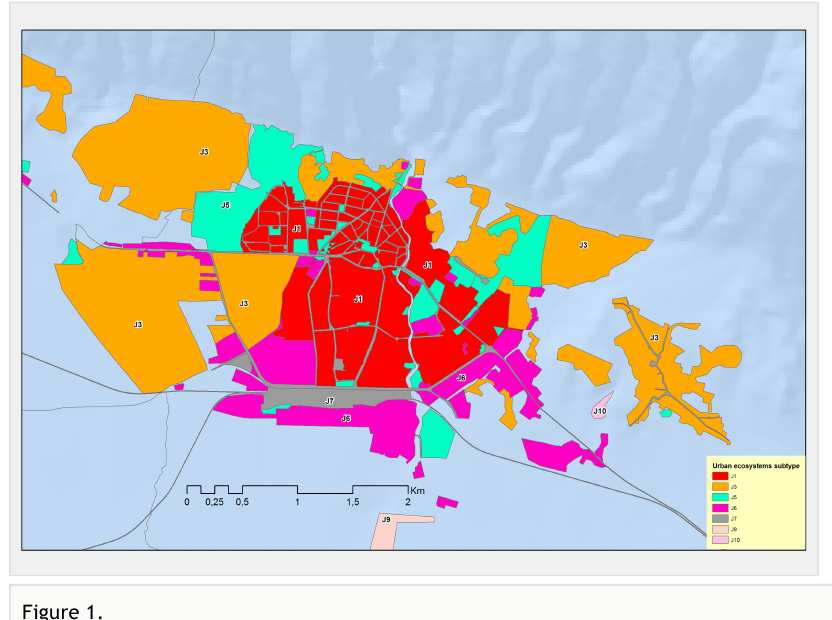
Figure 1. Spatial distribution of urban ecosystems in Karlovo (Urban ecosystem subtypes codes are explained in Table 1).